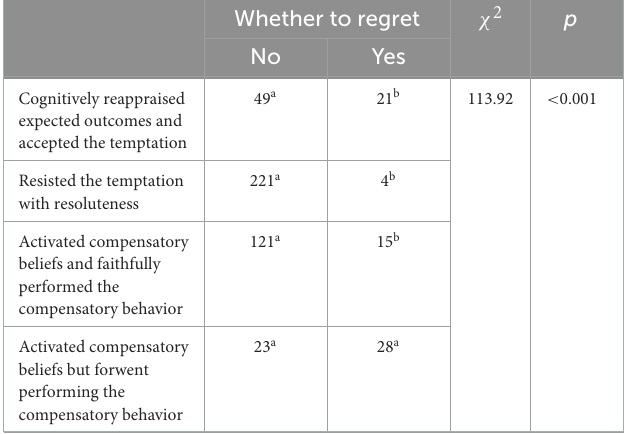
TABLE 2B Regrets of different options (organizational